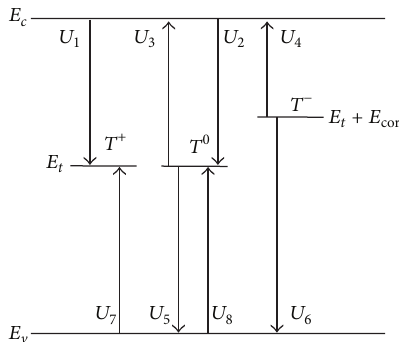
Figure 7: Schematic of electron flows for recombination at posi- tively correlated dangling